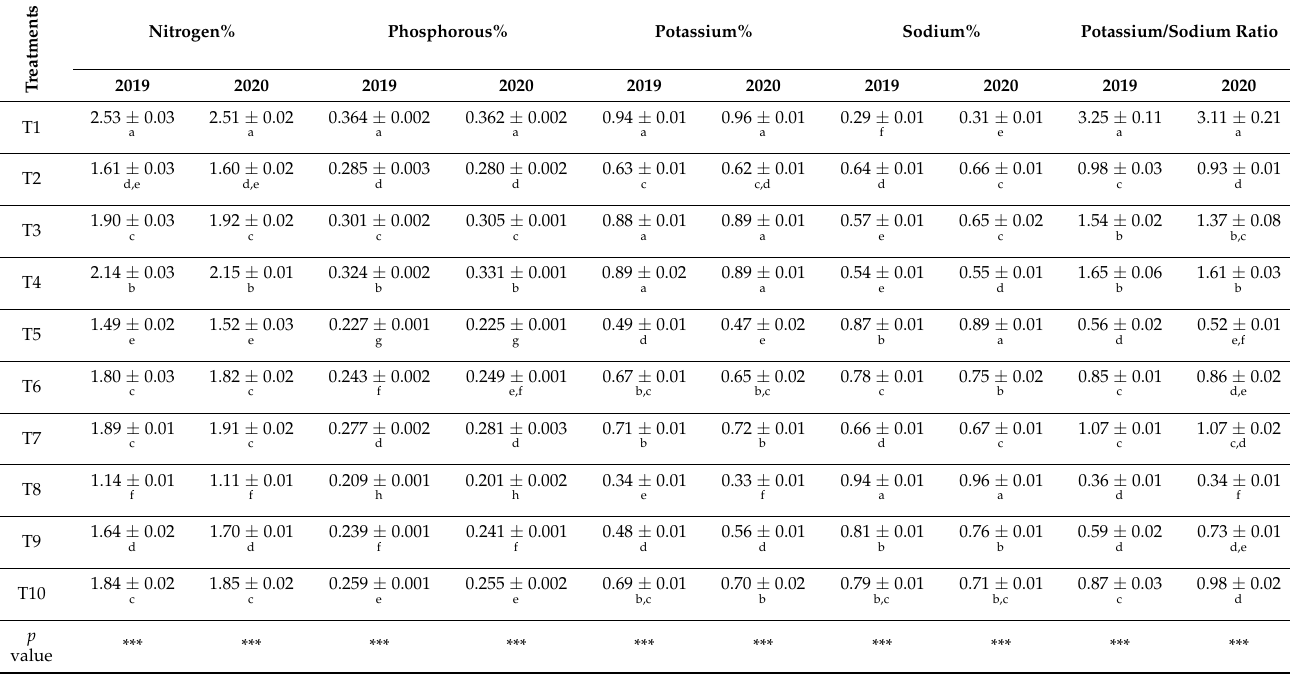
Table 2. Ions percentage and potassium/sodium ratio of grapevine seedlings as affected by salinity (NaCl) and brassinolide (BL) during both growing